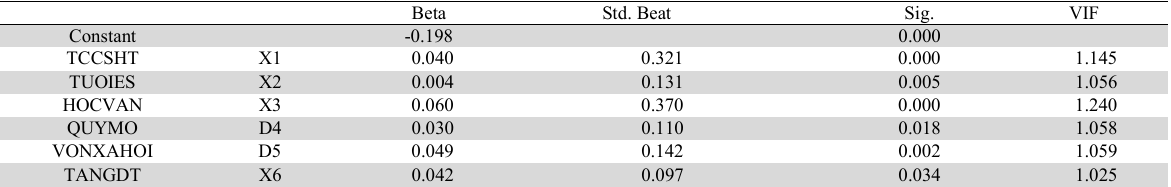
Durbin-Watson coefficient = 1.96 Adjusted R 2 =